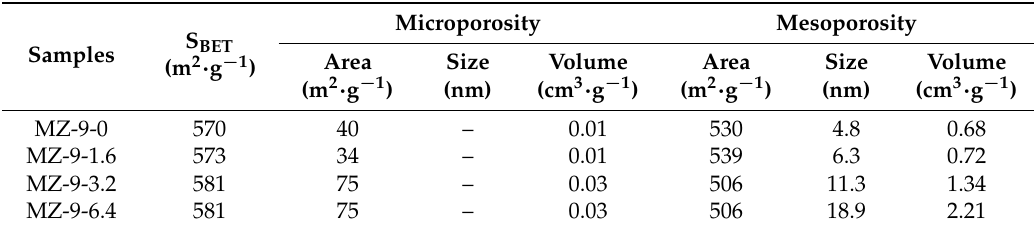
Table 4. Pore parameters of the